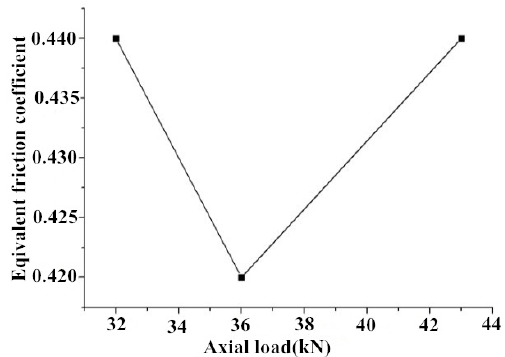
Figure 21. Equivalent friction coefficient.